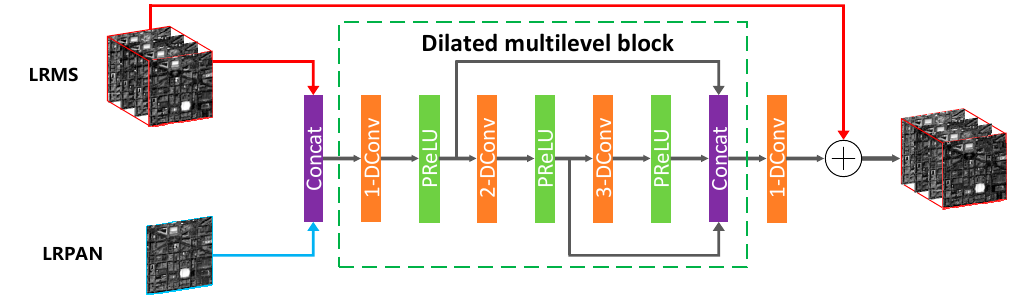
Figure 1. Architecture of the proposed dilated multilevel network.